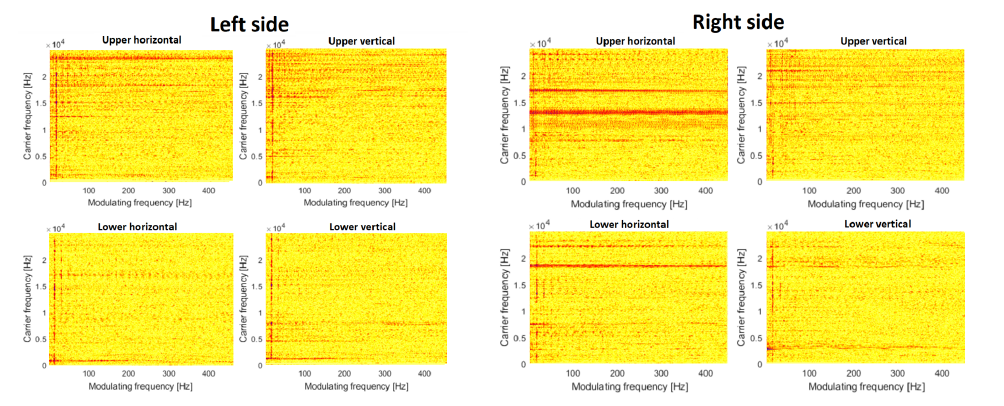
Figure 10. Cyclic spectral coherence (CSC) before repair.